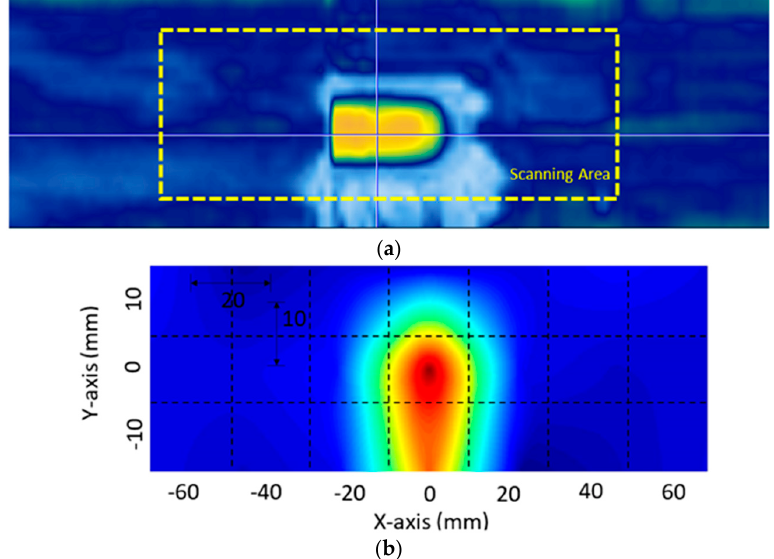
Figure 10. Visualization of the adhesive bonded aluminum plate 2: ( a ) C-Scan result and ( b ) result obtained using the proposed imaging algorithm.